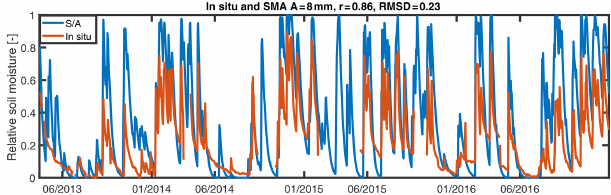
Figure 3. Relationship between S/A and observed soil moisture data between 8 April 2013 and 31 December 2016 for different val- ues of A (Rheraya basin).